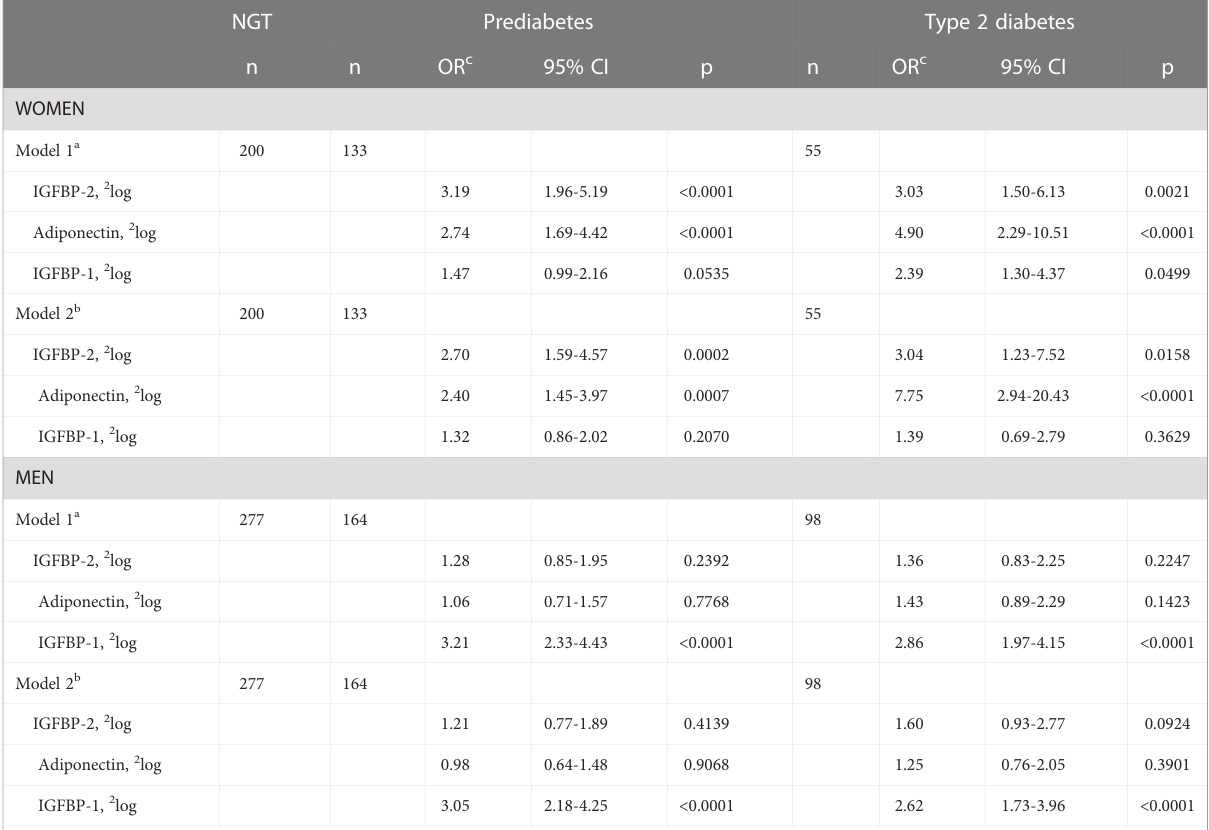
TABLE 3 Odds ratios (ORs) for decreasing values of IGFBP-2, adiponectin and IGFBP-1 measured at baseline and included in the same regression model in the association to development of prediabetes and type 2 diabetes at follow-up in women and men. NGT Prediabetes